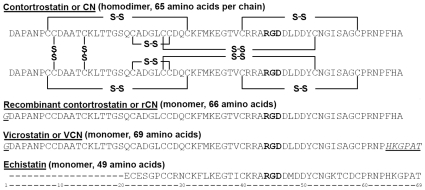
Comparison between contortrostatin (CN), recombinant contortrostatin (rCN), vicrostatin (VCN), and echistatin sequences.Mass spectrometry and crystallographic data have confirmed that CN is a dimer with two identical chains oriented in an antiparallel fashion and held together by two interchain disulfide bonds. Unlike native CN, mass spectrometry showed that both rCN and VCN are monomers. In the above sequences, the Arg-Gly-Asp tripeptide motif is depicted in bold whereas the non-native amino acids in rCN and VCN are both italicized and underlined.